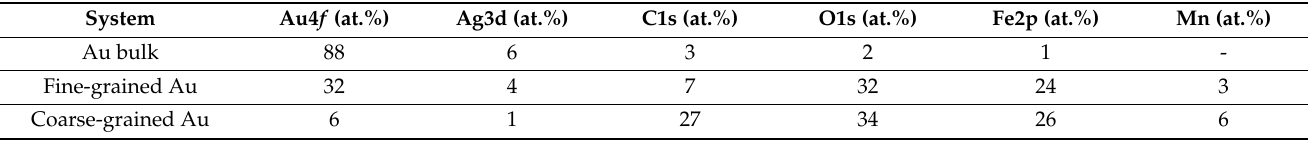
Table 2. Results of quantitative analysis of XPS core levels for bulk Au, fine-grained, and coarse-grained Au concentrate samples.